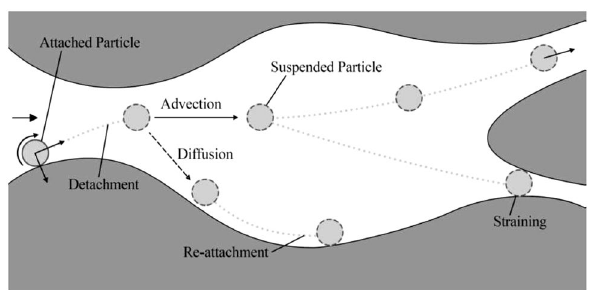
Fig. 7 Schematic of the particle transport in porous media and its related physical mechanisms—particle mobilization, migration, diffu- sion, and straining (courtesy Russel et al. 2017)